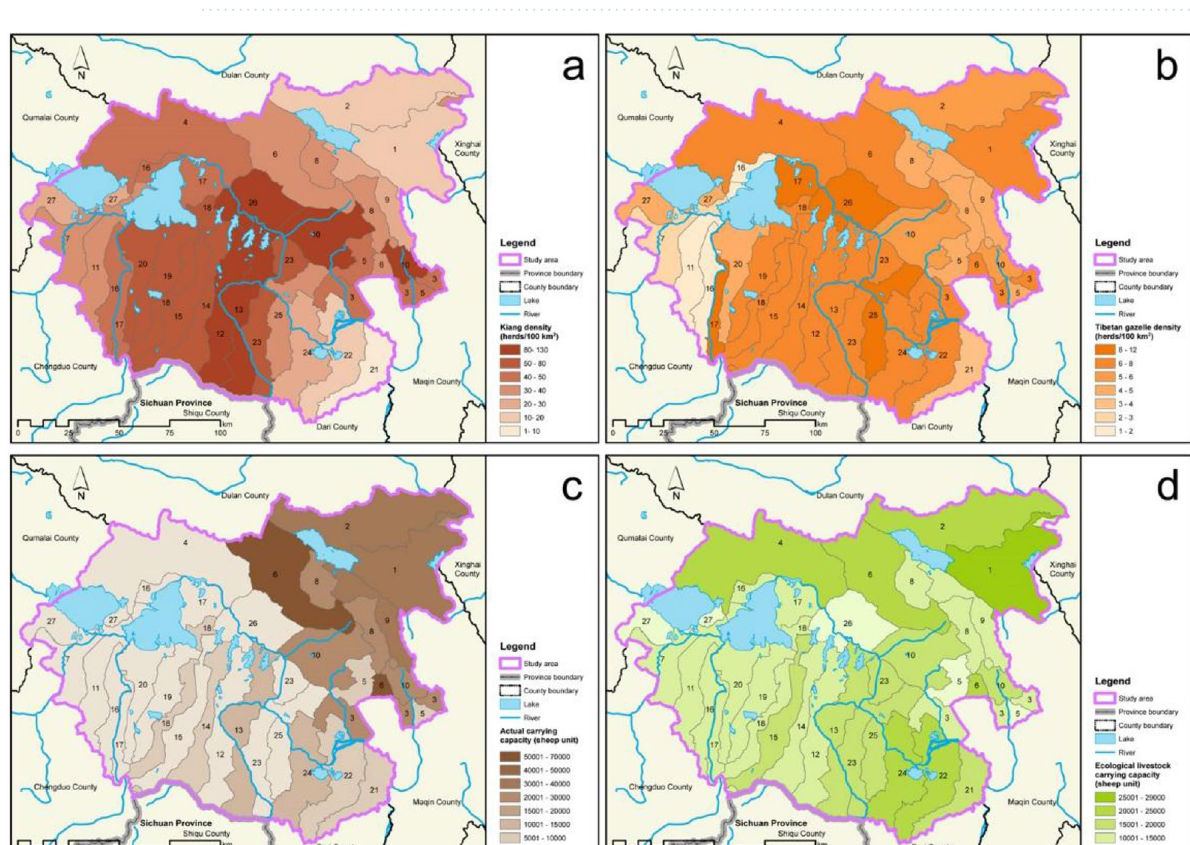
Figure 3. The density spatial distribution of kiangs ( a ) and Tibetan gazelles ( b ), the actual carrying capacity ( c ) and the ecological carrying capacity ( d ) of Maduo County. Maps were produced in ArcGIS 10.2 (https :// deskt op.arcgi s.com/en/) based on shapefiles and data collated for this study, and Adobe Illustrator was used to combine them into one